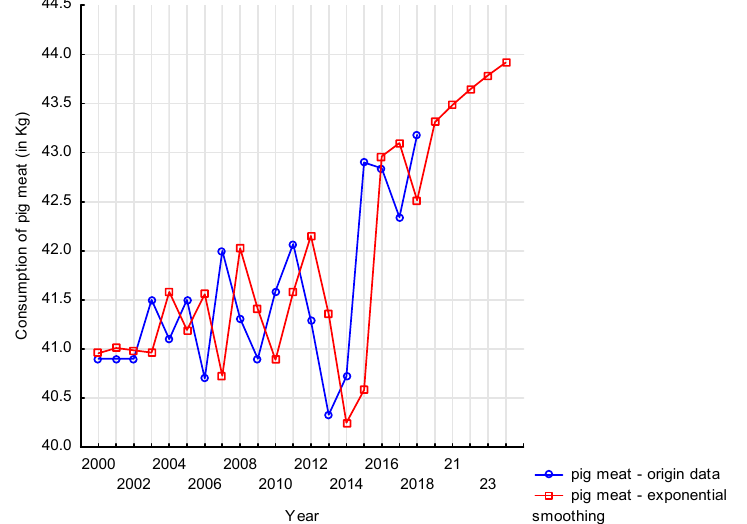
Figure 15. Prediction of pork consumption in the Czech Republic until 2024 [27].